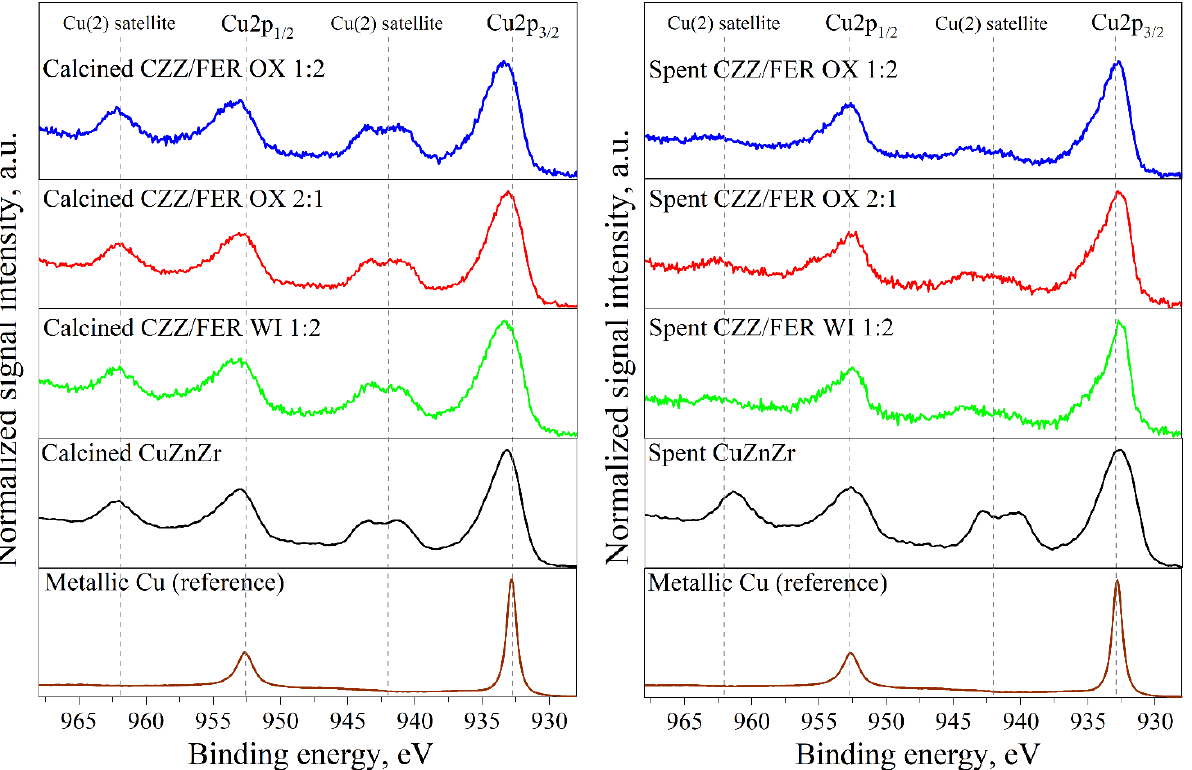
Figure 4. Cu2p high-resolution spectra for all the XPS tested samples and metallic Cu reference for comparison. For clearness, each spectrum was normalized with respect to the maximum height of the Cu2p 3/2 peak.